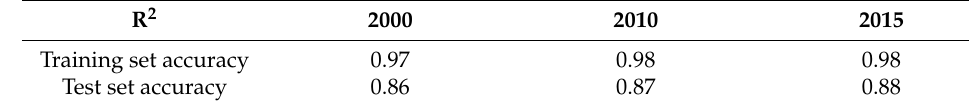
Table 7. The goodness of fit (R 2 ) values of the RF model.